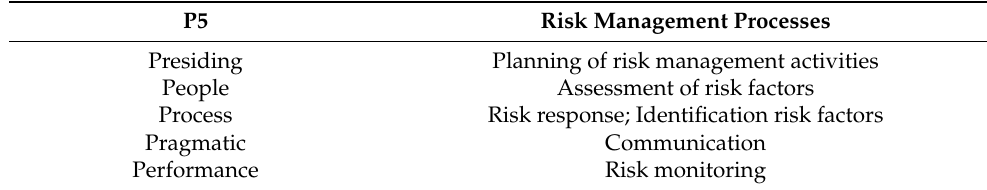
Table 6. Risk management processes and GPM P5 Standard for Sustainability in Project